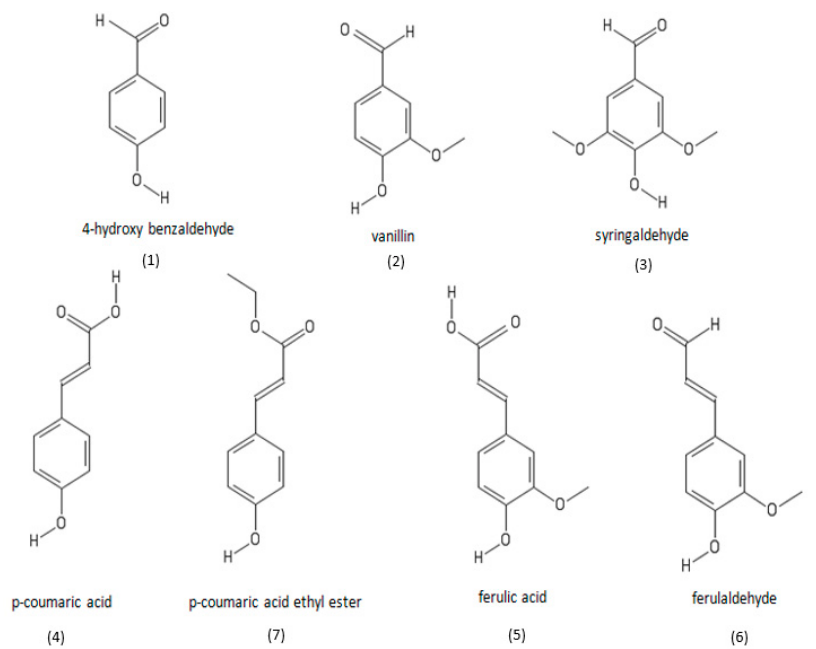
Figure 3. Structural formulas of phenolic compounds identified in cactus seed oil.